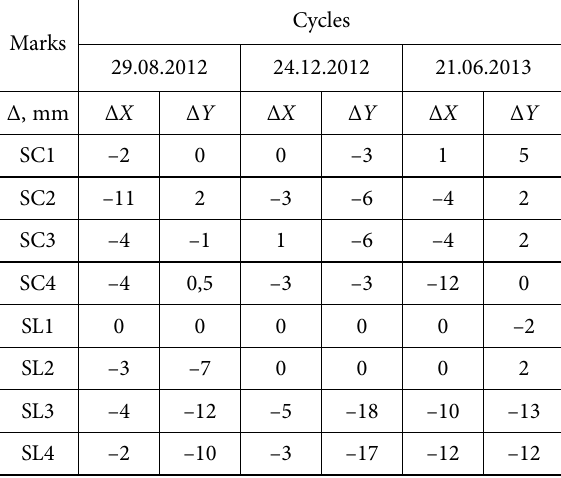
Table 1. The calculated displacement